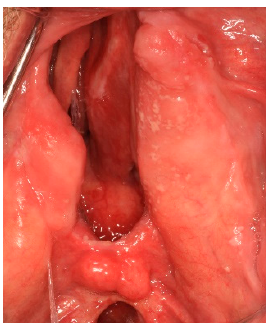
Figure 2. The hard and soft cleft palate intraoral defect. Preliminary maxillary and mandibular impressions were made using irreversible hydrocolloid material (BluePrint ® X-creme; Dentsply Int, York, PA, USA) and the obtained casts were used for the fabrication of maxillary and mandibular custom trays. A modeling impression compound (Green stick impression compound; Kerr Corp., Brea, CA, USA) was used to border-mold the basal area of the tray (Figure 3) and the hard palate cleft defect, whereas the final wash was performed using a polysulfide impression material (Permlastic; Kerr Corp) (Figure 4). The undercuts in the maxillary master (Figure 5) cast were blocked-out with baseplate wax, and the maxillary record base was fabricated. For the mandibular final impression, the vertical and centric relation records, the set up of the teeth, the try-in procedures, and the laboratory steps, techniques and guidelines used in the fabrication of conventional complete dentures were followed. The maxillary obturator prosthesis was processed, placed intraorally, and the necessary adjustments were made. In order to record the contours of the velopharyngeal musculature and to add the pharyngeal extension of the prosthesis, functional tracing, with a resilient acrylic relining material (Trusoft; Hary J. Bosworth Co., Skokie, IL, USA), was performed. The contours of the defect were functionally recorded while the patient swallowed, spoke, made a circular head movement, and breathed over a 20-minute period (Figure 6). Articulation and resonance were evaluated in collaboration with a speech pathologist. The necessary follow up adjustments were made, the nasopharyngeal extension impression was converted to heat polymerized acrylic resin (Lucitone 199; Dentsply Sirona, Charlotte, NC, USA), and the prosthesis was delivered to the patient (Figure